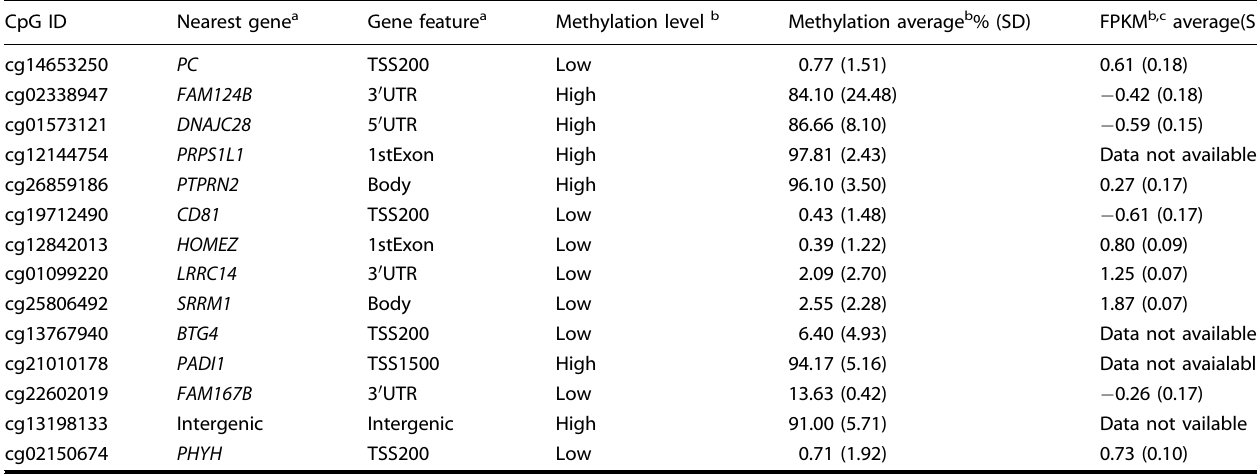
Table 4. Relationship between DNA methylation and gene expression as reported in the IMETHYL database. CpG ID Nearest gene